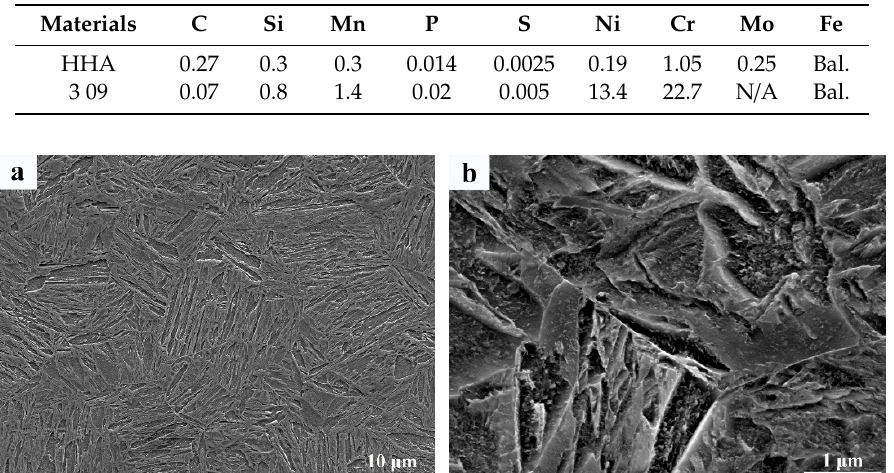
Table 1. Chemical composition of armour steel and 309 interlayer (wt. %).